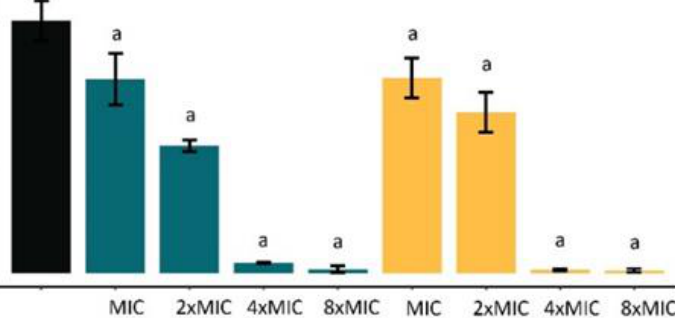
Figure 4. Effect of RIP3 on the viability of ex vivo biofilms (nail fragments) of dermatophytes determined by quantifying the number of colony-forming units (CFU). The results are the means ± SD from three independent experiments. Significant difference ( p < 0.05) when compared to drug-free growth control (a) and CPX at the respective MIC value (b). OD, optical density; MIC, minimal inhibitory concentration; RIP3, riparin III; CPX, ciclopirox. Table 2. Ex vivo production of biofilm (nails fragments) by dermatophytes in the absence (control) and presence of RIP3.